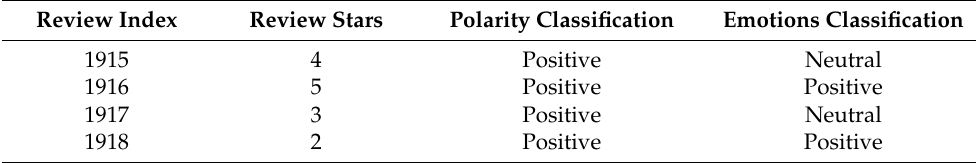
Table 2. Extract of Reviews